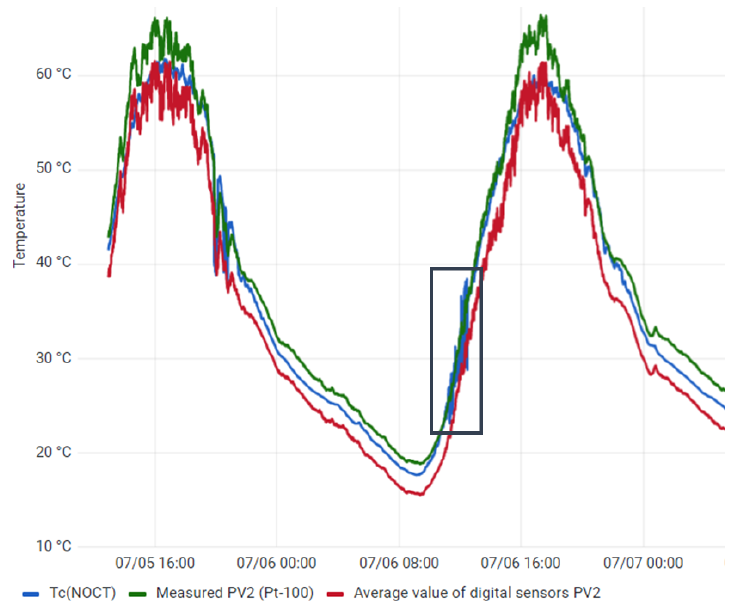
Figure 4. Fluctuations of model estimations due to shadow effect.